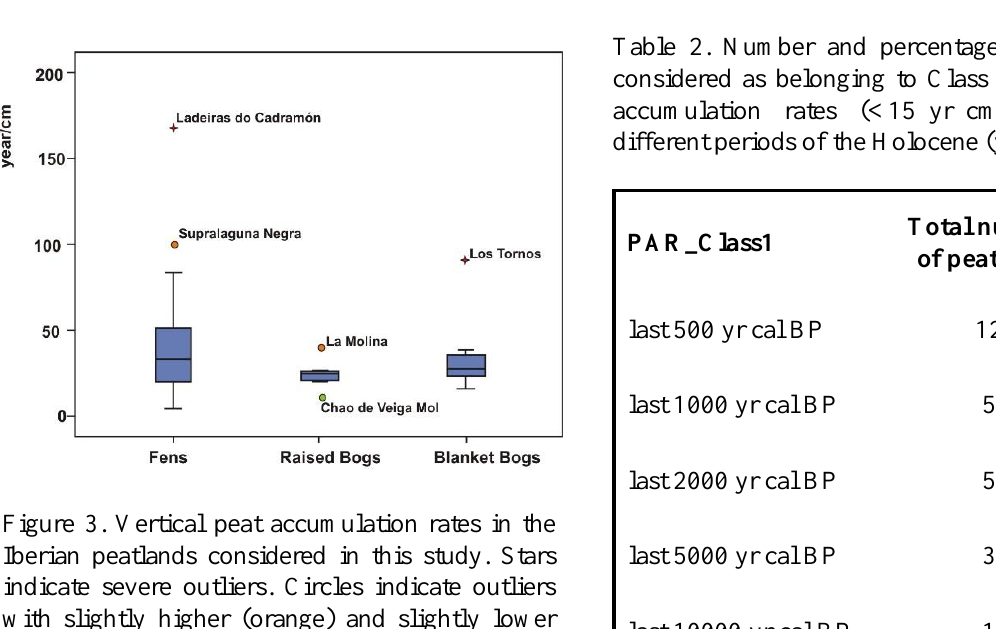
(PAR range: 16–30 yr cm -1 ) represented 41 % of all types. Combining this class with the second most abundant class (PAR range: 31–60 yr cm -1 )